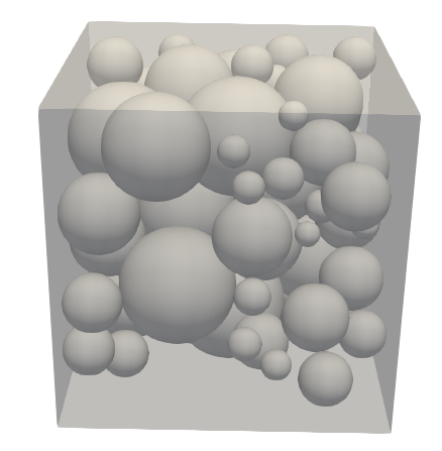
Figure 27. Particulate system with 84 spherical